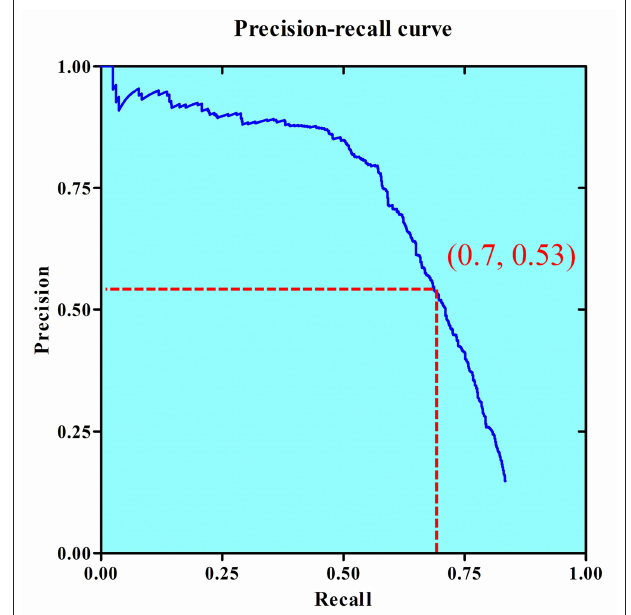
FIGURE 3 | The precision–recall curve of the InterNet. The average precision of the InterNet was 64.5 on the evaluation dataset. We selected a spot with a recall of 0.7 and a precision of 0.53.